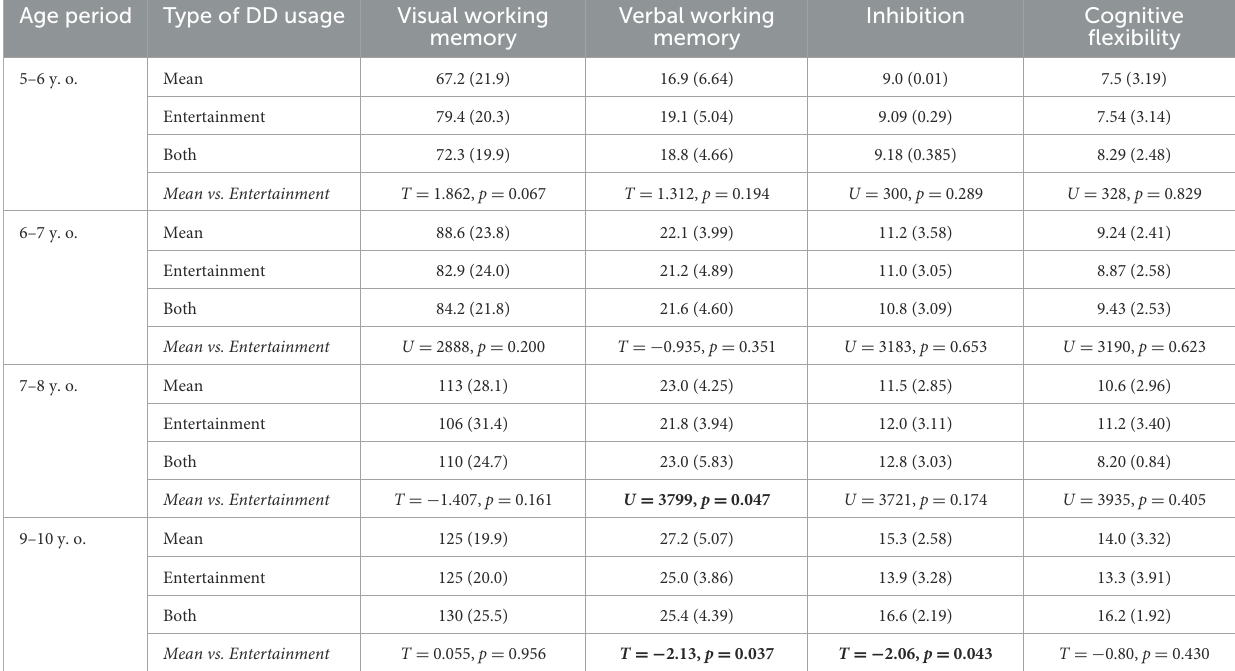
TABLE 2 Descriptive data for EF development in children from 5 to 10